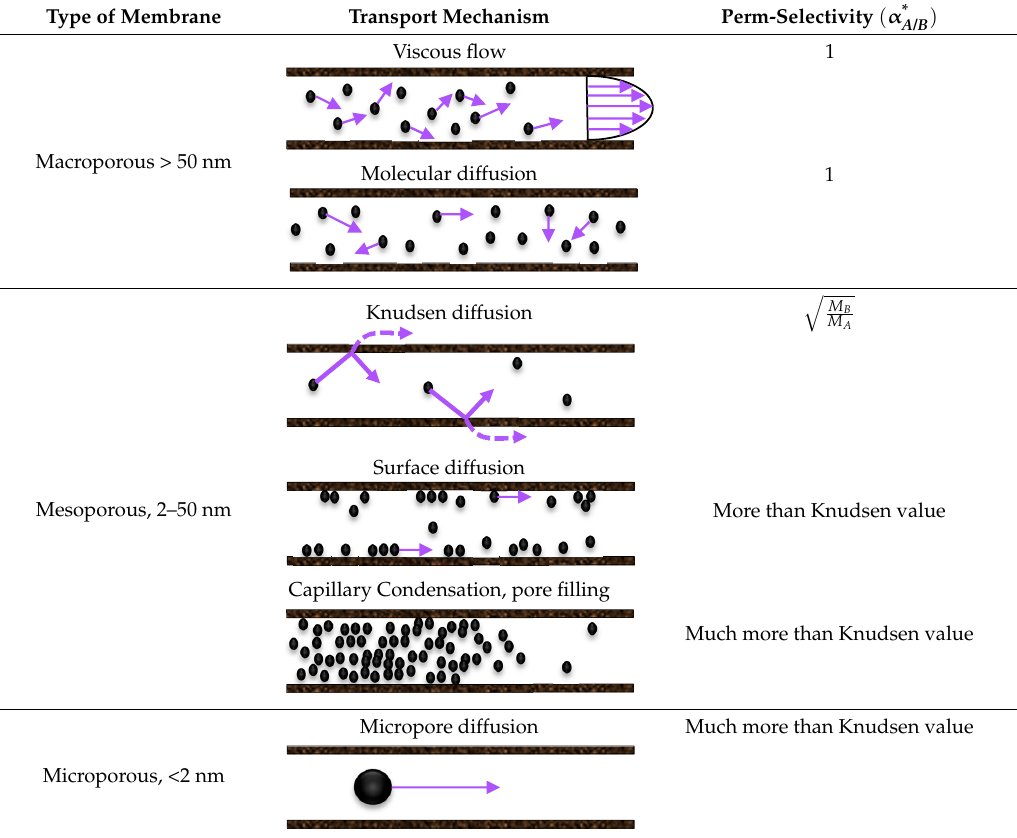
Table 2. Gas transport mechanism inside porous materials and their perm-selectivity.